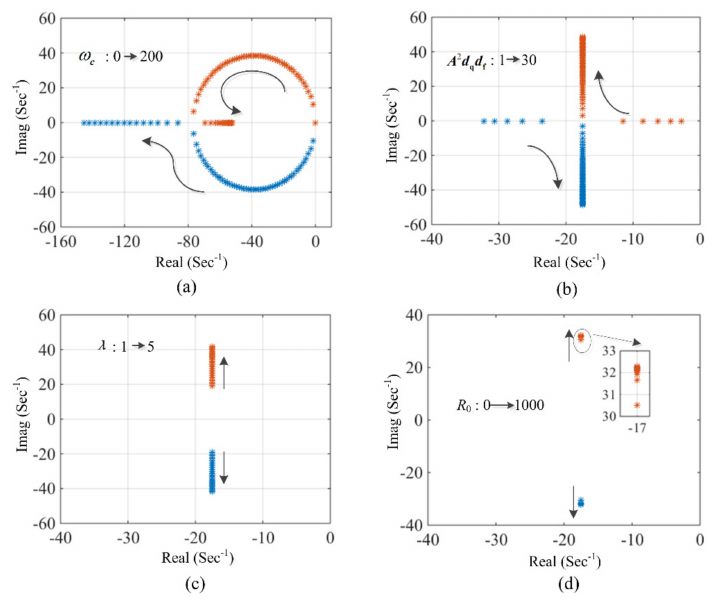
Figure 7. Root locus diagrams with the variation of ω c , A 2 d q d f1 , λ , and R 0 . ( a ) E ff ect of A 2 d q d f = 15, R 0 = 70, and λ = 1; ( b ) e ff ect of R 0 = 70, λ = 1, and ω c = 35 rad / s; ( c ) e ff ect of A 2 d q d f = 15, R 0 = 70, and ω c = 35 rad / s; ( d ) e ff ect of A 2 d q d f = 15, λ = 1, and ω c = 35 rad /